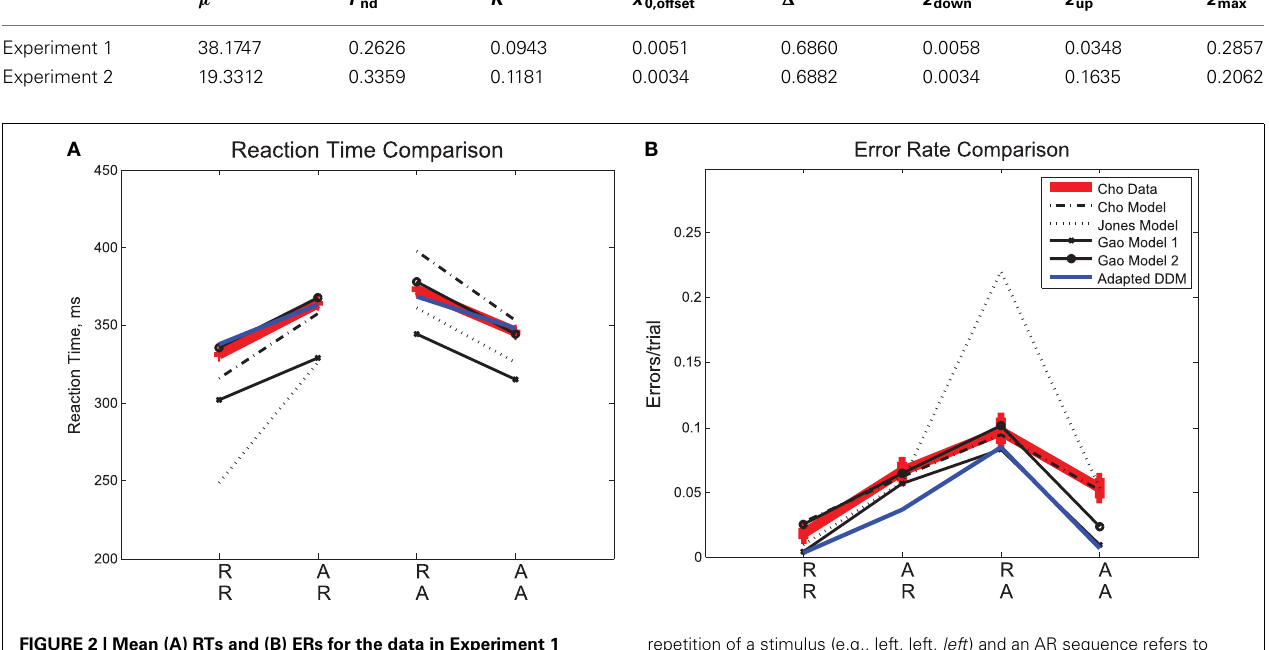
FIGURE 2 | Mean (A) RTs and (B) ERs for the data in Experiment 1 (Cho Data), the three published fits to the data (Cho, Jones, Gao), and the fit presented for this data in the adapted DDM of the present study. In the diagram, an RR sequence refers to the RT on the second